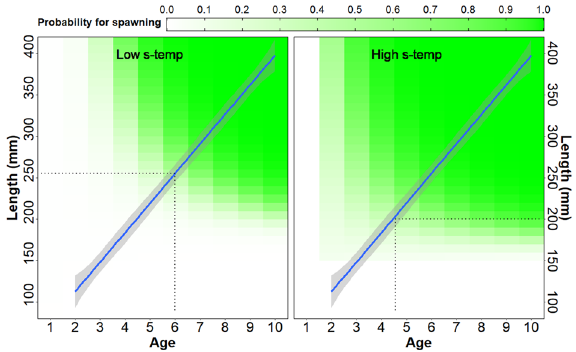
Figure 3. Contour plot representing variations in spawning probability (green shading) in relation to age (x-axis) and length in millimetres (y-axis). A value of 0.1 equals 10% probability of spawning, 0.2 equals 20% and so on. Left panel shows the spawning probability for lakes in the data experiencing low mean summer temperatures (10.8 °C), and right panel shows the spawning probability for lakes experiencing high mean summer temperatures (13.4 °C). Blue lines represent the estimated mean length at age across all the lakes and the corresponding shaded areas are 95% confidence bounds. The dotted lines indicate the approximate point of 50% probability to spawn in the two temperature scenarios. The figure has been made using the ggplot2- library 68